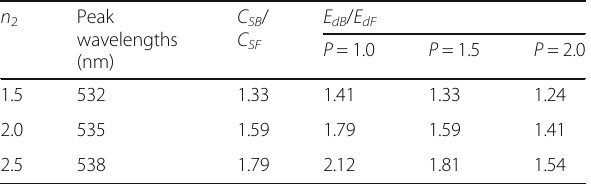
Table 3 Simulated C SB / C SF and calculated E dB / E dF using Eq. (4) of structure B with different P coefficients